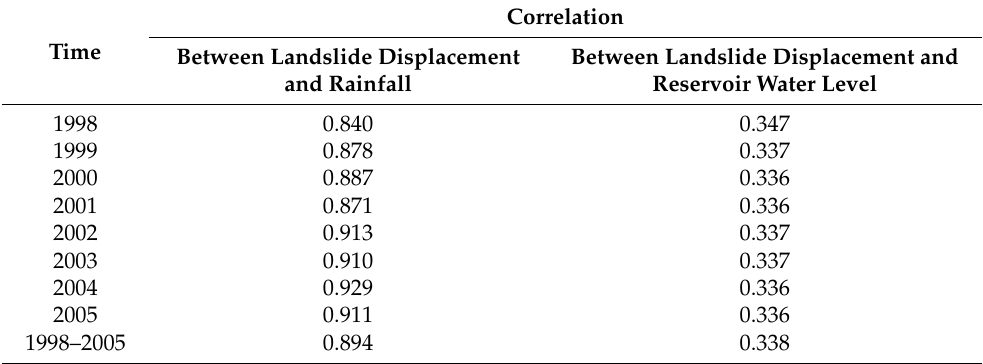
Table 1. The grey correlation analysis results between landslide displacement and rainfall/reservoir water